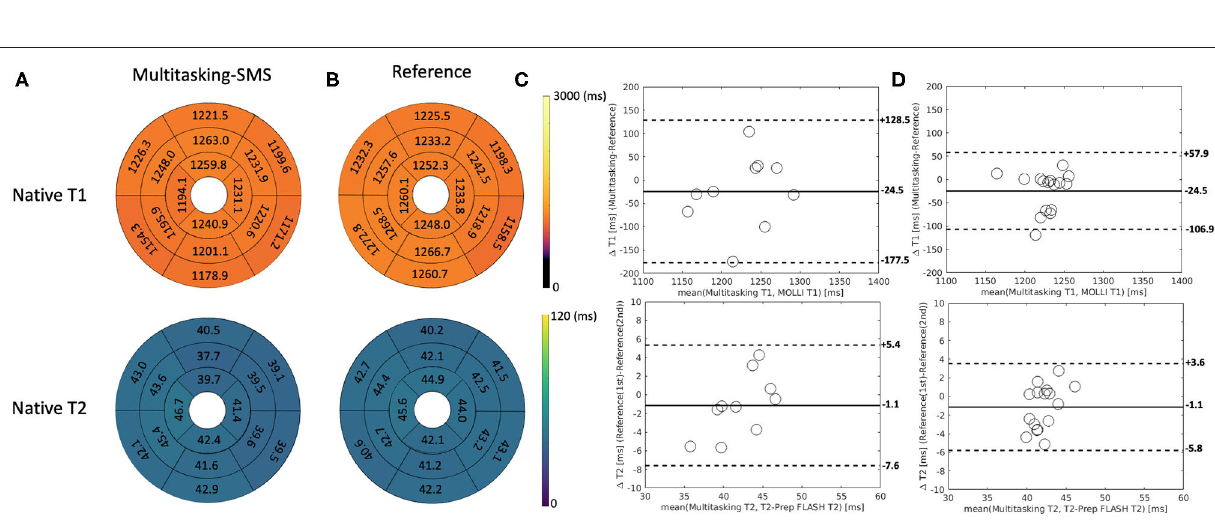
Frontiers in Cardiovascular Medicine |